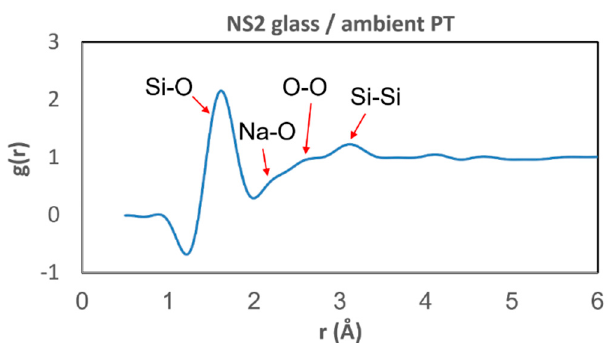
Figure 9. The pair distribution function g(r) of sodium disilicate glass collected at ambient pressure and temperature. Peaks representing atomic distances of Si–O, Na–O, O–O and Si–O are